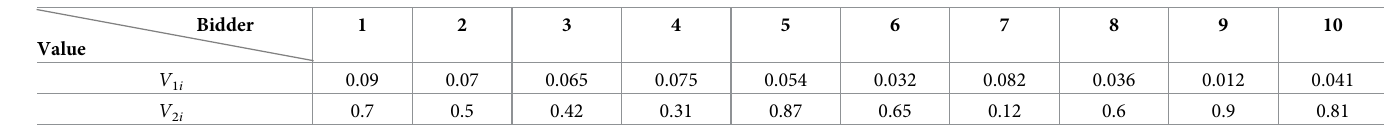
Table 2. Values of the land quota and construction land of